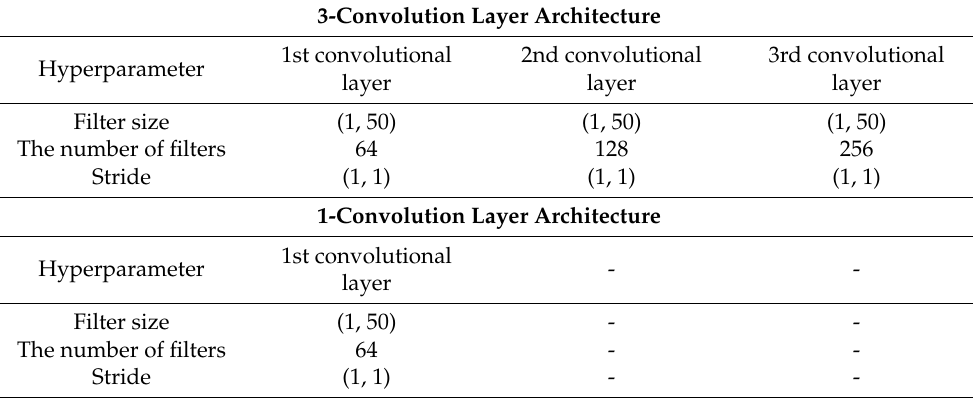
Table 6. Convolutional layer hyperparameter